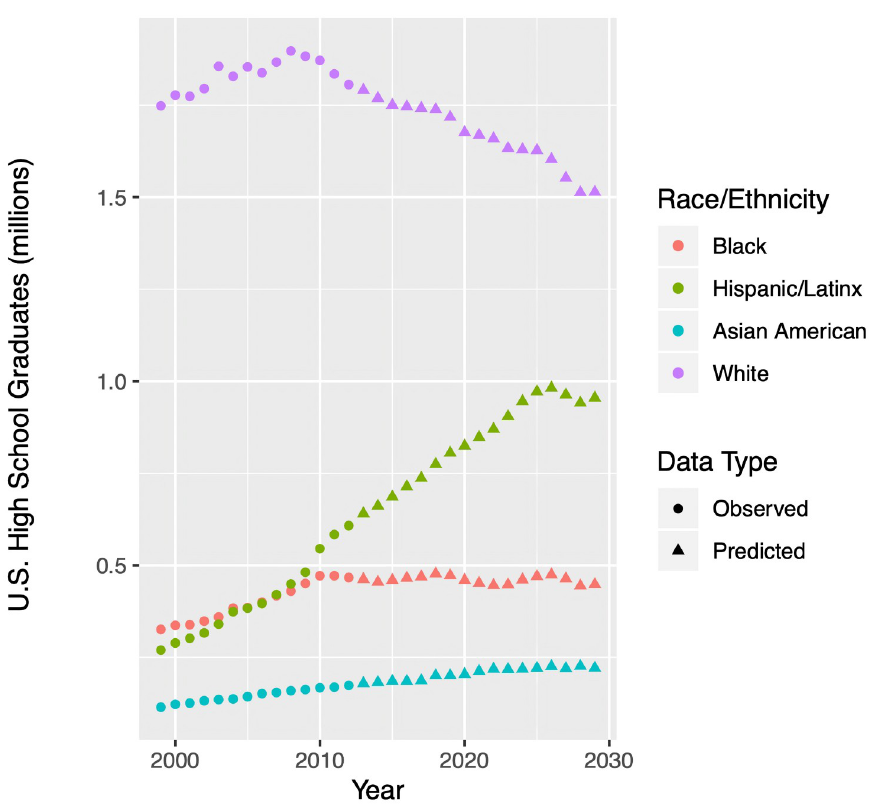
Fig 2. U.S. high school graduates by year and racial/ethnic group. Observed and predicted counts of public high school graduates in the U.S. between 1999 to 2029, in millions, according to data from the NCES [9]. The graph shows measured data through 2013 (circles) as well as NCES projections after 2013